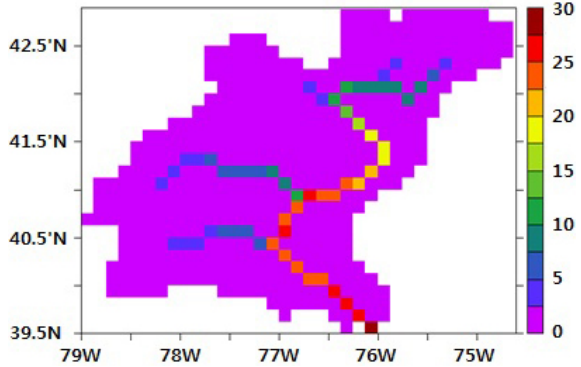
Figure 10. N removal by river denitrification (%) = (river N load 0 = 0” – river N load with “estimated k 0 with “ k denitr 0 = 0” × load with “ k denitr